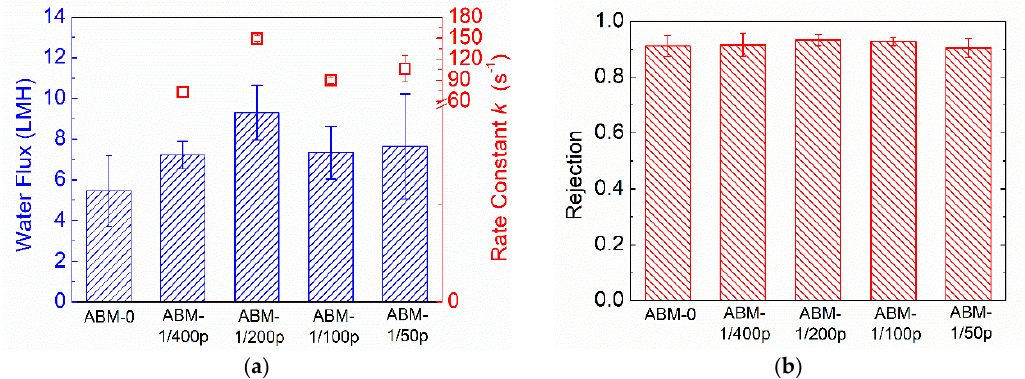
Figure 3. Impacts of PLR on ( a ) water flux and ( b ) rejection of ABM. ABM-0 indicates membranes without incorporation of proteoliposomes. The concentration of proteoliposomes in MPD solution was 0.016 wt% for all AqpZ-containing membranes. RO testing was conducted at 5 bar, with 10 mM NaCl solution as a feed solution. The error bars were derived from results for 3 independent membrane samples.